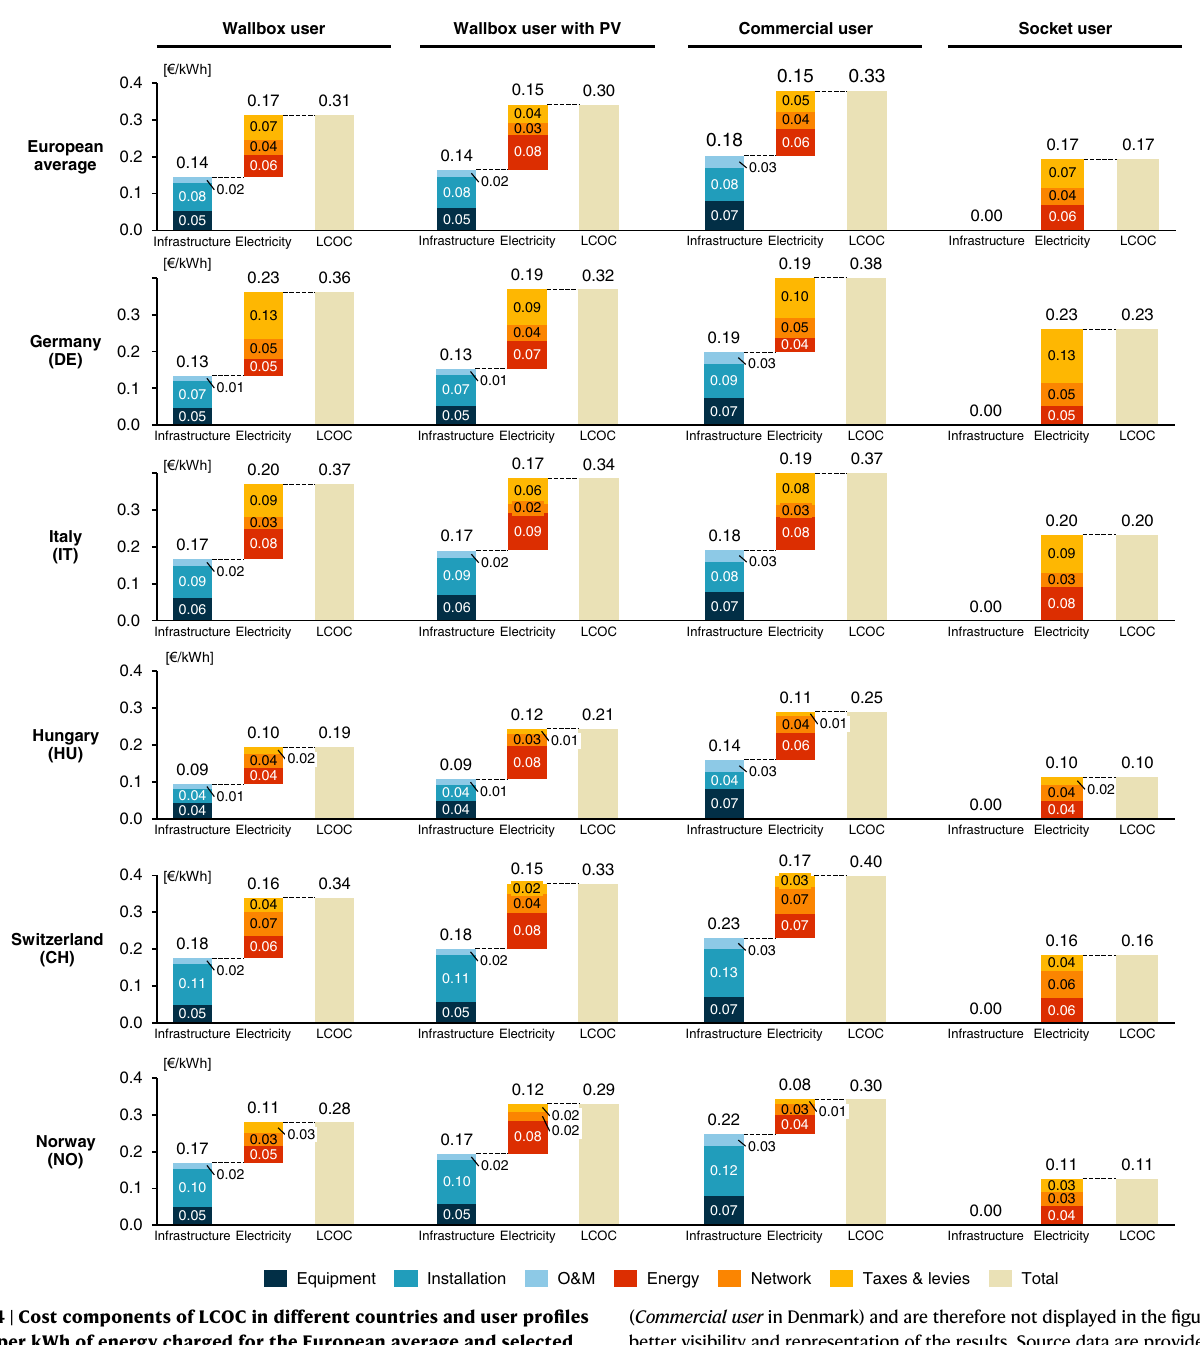
( Commercial user in Denmark) and are therefore not displayed in the fi gure for better visibility and representation of the results. Source data are provided as a Source Data fi